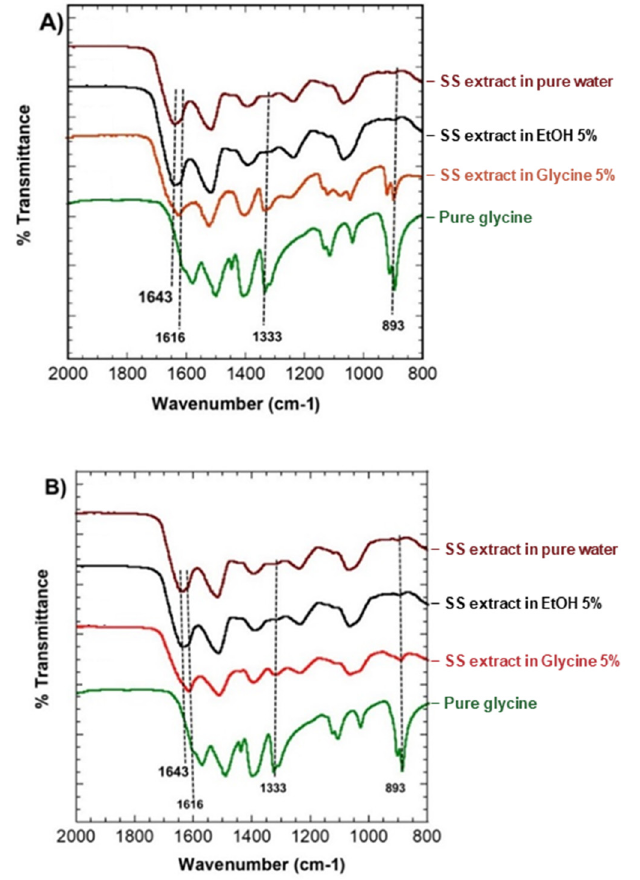
Figure 10. IR spectroscopy of ( A ) SS solution film ( B ) Gel film dried at 60 °C. The samples were SS extract in pure water, EtOH 5%, glycine 5%, and pure glycine spectrum, respectively.